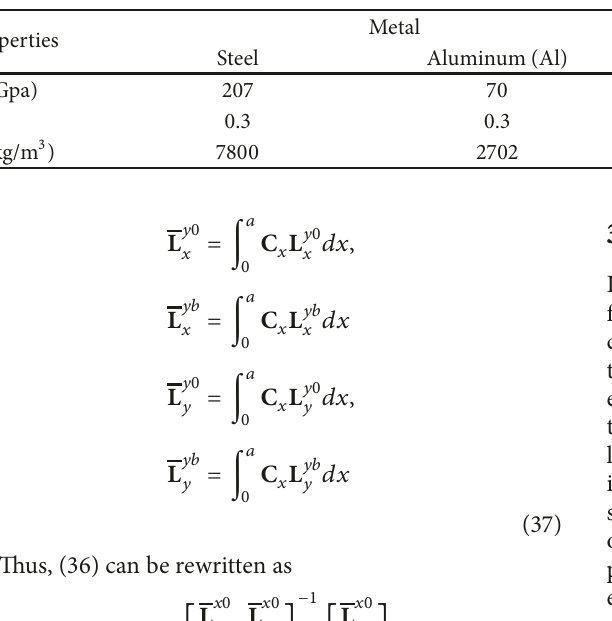
Table1:MaterialpropertiesusedintheFGplate.Table 1isreproducedfromWang[42]etal.(2017)(undertheCreativeCommonsAttribution License/public domain).